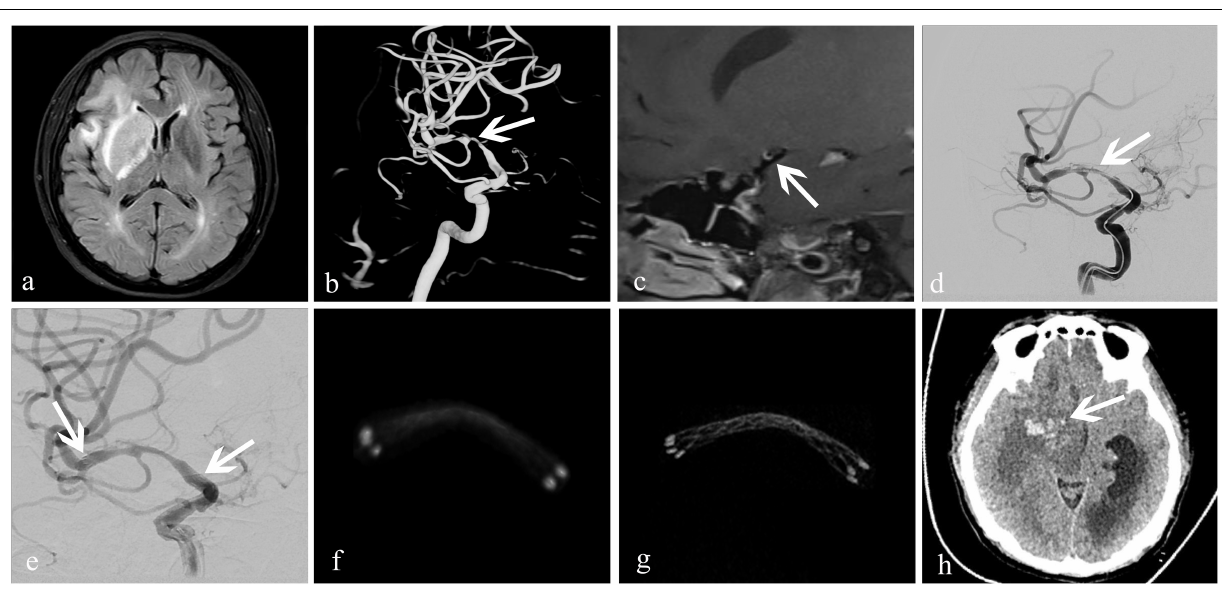
1 ( n = 24), 2 ( n = 1), and 3 ( n = 1). In the follow- up window, 3.5% (4/114) of patients had ischemic strokes, of which one resulted in permanent disability and three